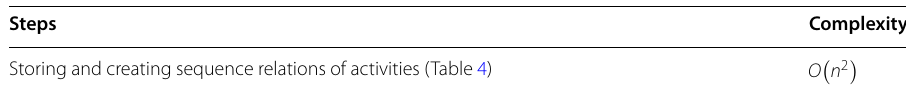
Table 9 Comparison of algorithm complexity GIT algorithm